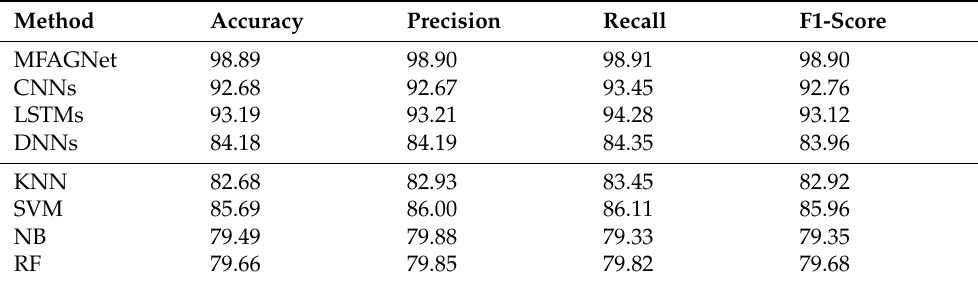
Table 6. Recognition accuracy (%) of combination